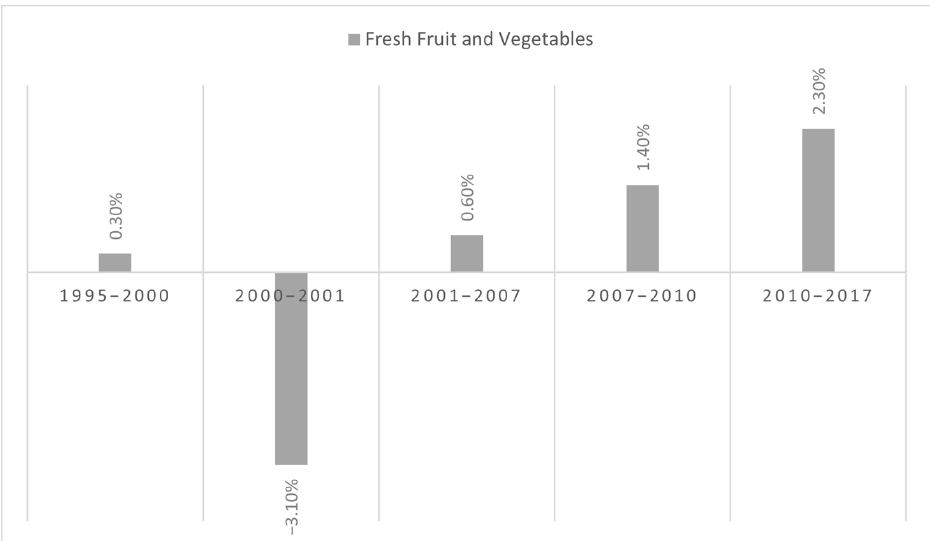
Figure A2. Percentage change in USD spend for fresh fruit and vegetables, 1995–2017 (inflation-adjusted; CAGR). Source: Deloitte Analysis of Consumer Expenditure Surveys data, sourced from the US Bureau of Labor Statistics [57].